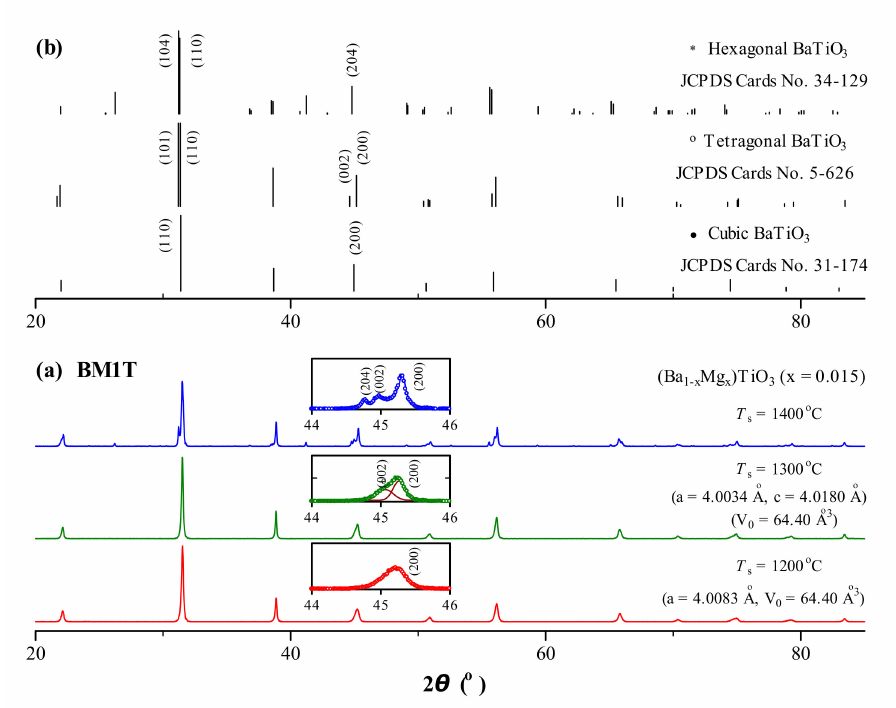
Figure 1. ( a ) Powder XRD patterns of (Ba 1 − x Mg x )TiO 3 ( x = 0.015) (BM1T) ceramics prepared at T s = 1200–1400 ◦ C. Insets show enlarged di ff raction peaks in the vicinity of 45 ◦ . The lattice parameters are given. ( b ) Simulated XRD patterns of BaTiO 3 with cubic, tetragonal, and hexagonal structures.